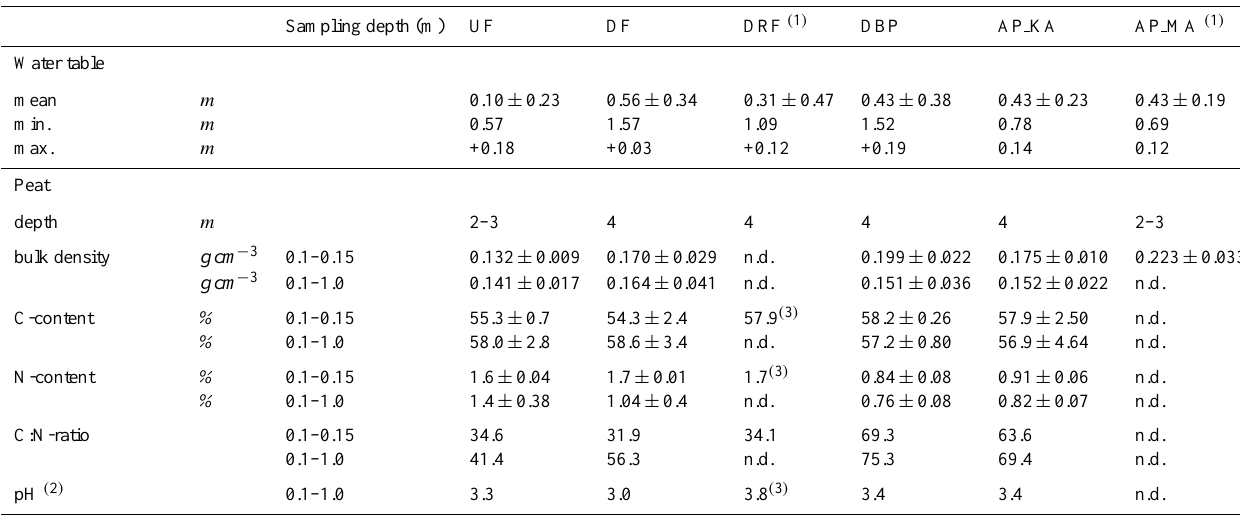
Table 2. Summary of general peat and water table (WT) depth characteristics at the flux monitoring sites. Means are shown with standard